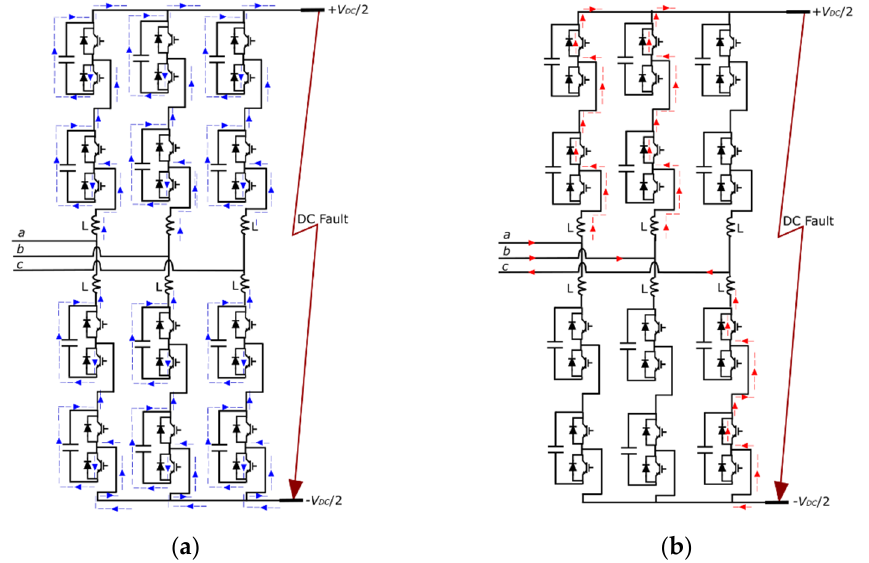
Figure 4. Pole-to-pole fault current path in HBSM-MMC during ( a ) Stage 1; ( b ) Stage 3. During a DC side fault in the HBSM-MMC, the IGBTs are blocked. For a positive SM current ( i sm > 0) in Figure 2a, diode D1 and the capacitor in each of the SMs are in the fault current path. Therefore, the total capacitor voltage of the HBSMs in each MMC arm would equal V DC . If the fault on the DC side is a pole-to-ground fault, then the peak AC side voltage would be equal to V DC /2 from (1) and (2). Since the reverse voltage generated by the MMC arm would be greater than the peak AC grid phase voltage, diodes D1 in the HBSMs will be reverse biased, and the fault current would be suppressed. However, for i sm < 0, as shown in Figure 2b, the SM capacitors are bypassed entirely, and no reverse voltage would be inserted by the SM capacitors in the current path. Therefore, the AC side source will feed the pole-to-ground fault on the DC side. In the case of a pole-to-pole fault on the DC side, as shown in Figure 5, the peak line-to-line AC side voltage would √ be 3 V DC /2. For i sm > 0, the arms of the MMC will insert a total reverse voltage of 2 V DC in each phase while the arms will be bypassed for i sm < 0. The fault current path in the HBSM-MMC for a pole-to-pole fault is shown in Figure 5. Regardless of the type of fault, the HBSM is incapable of blocking the AC grid contribution to the DC fault